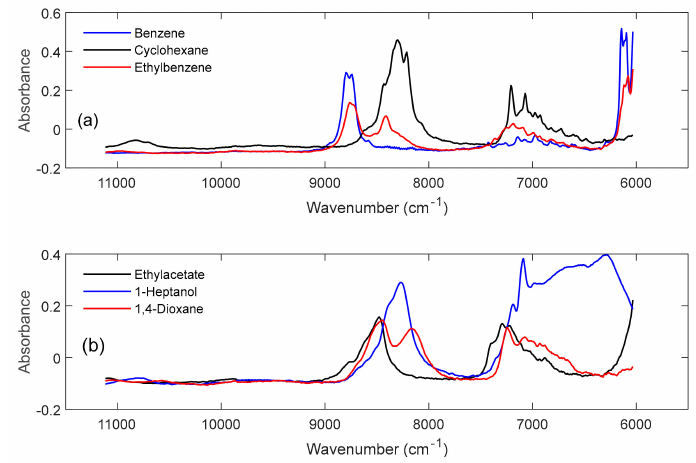
Figure 1. NIR spectra of the pure components of system 1 ( a ) and system 2 ( b